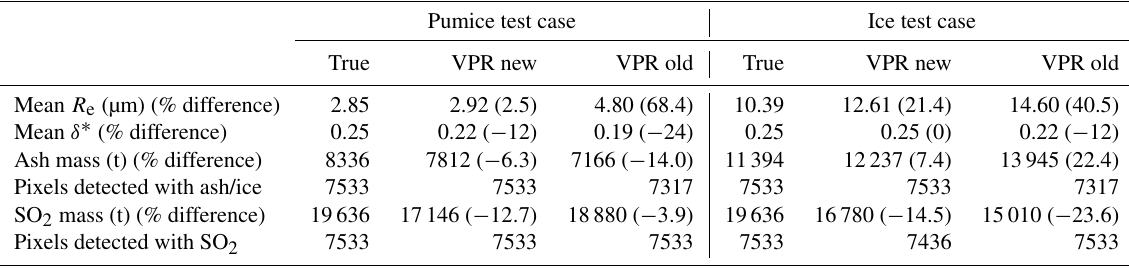
Table 4. Main characteristics of synthetic image, indicated as “true”, together with the results of the VPR procedure, both new and old versions. The percentage differences are shown in brackets.